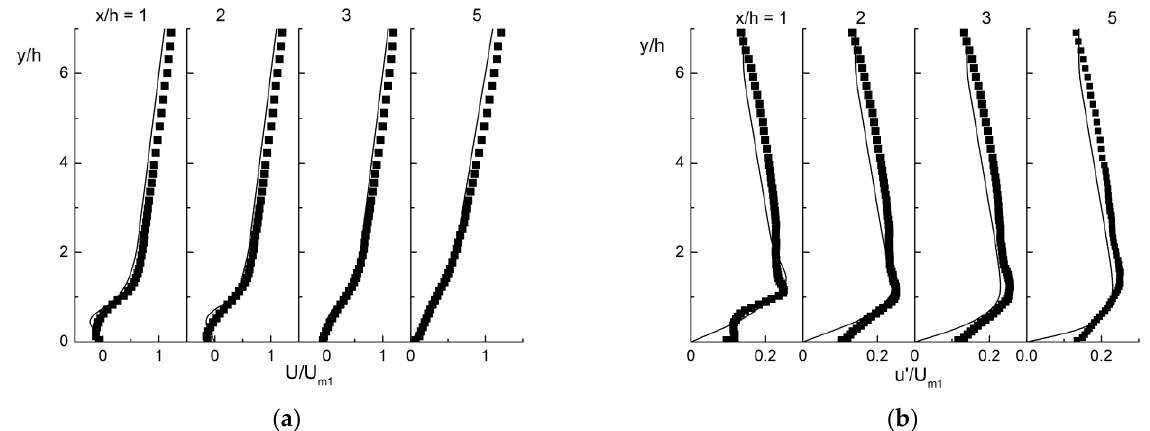
Figure 4. Profiles of the mean longitudinal velocity ( a ) and its fluctuations ( b ) in the flow around a two-dimensional square obstacle. ( a ): h / H = 0.067, Re = U m 1 H / ν = 5 × 10 4 , p / h = 9, H = 60 mm, h = e = 4 mm, p = 36 mm, U m 1 = 12.5 m/s. The symbols are the measurements of [39]; the lines are the authors’ simulations.